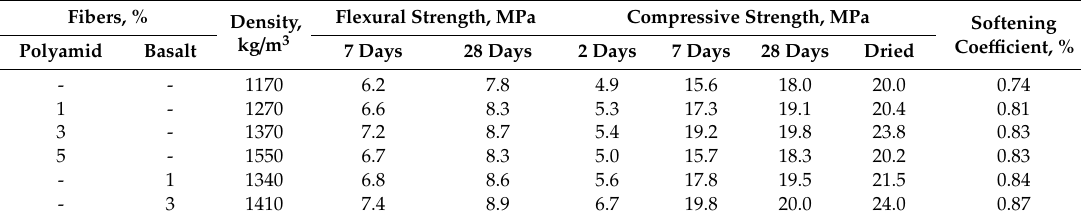
Table 9. Physicomechanical characteristics of the gypsum-cement fiber-reinforced composite (GCFRC).